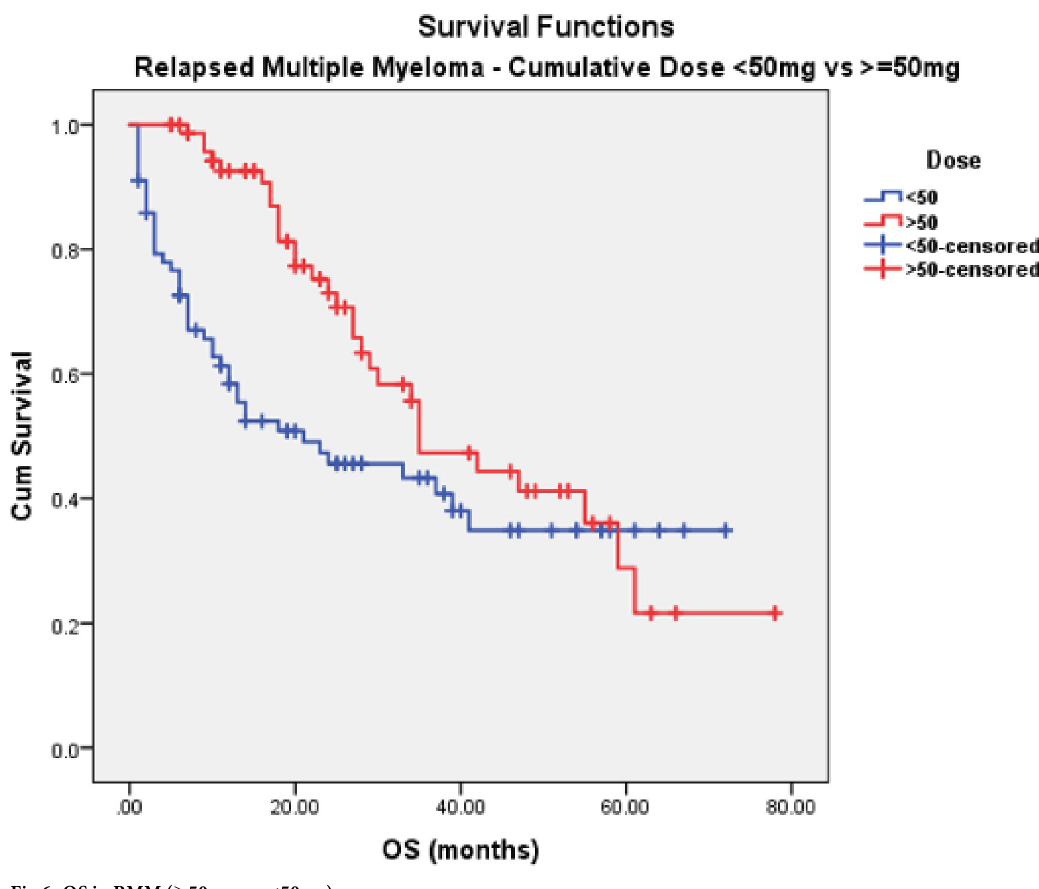
Fig 6. OS in RMM ( � 50mg vs. < 50mg).